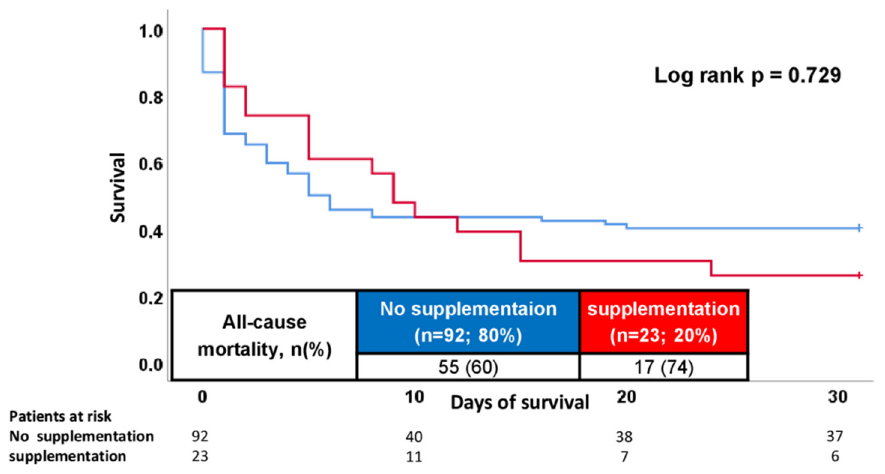
Figure 5. Prognostic impact of albumin supplementation on the risk of all-cause mortality at 30 days in patients with hypalbuminaemia.